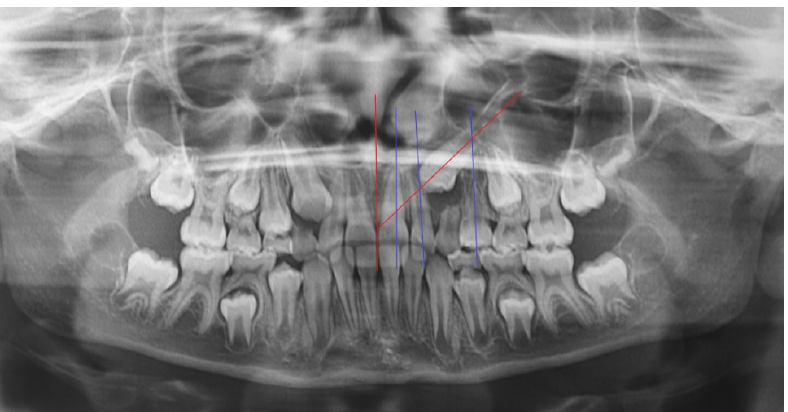
Figure A5. Pretreatment panorex of patient L.C.: high vestibular impaction of 2.3; α angle 48°, α sector 2–3.